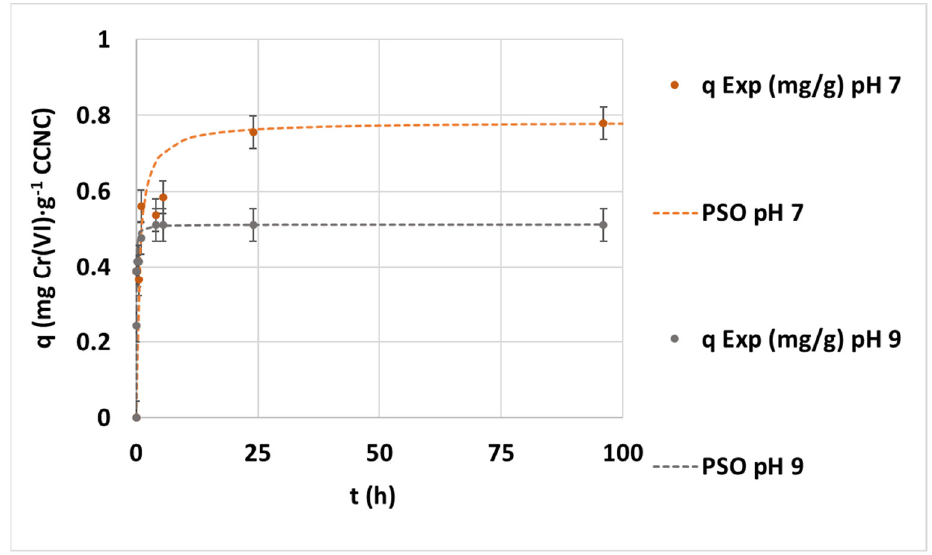
Figure 4. Evolution of the kinetic adsorption experiment at 0.1 mg·L −1 of initial chromium concen- tration, 100 mg·L −1 of CCNC dosage and room temperature under pH 3, 7 and 9 conditions and the kinetic fitting of PSO.